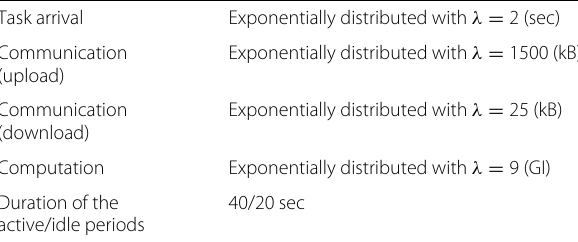
Table 4 Overview of selected load indicators from the theoretical model according to